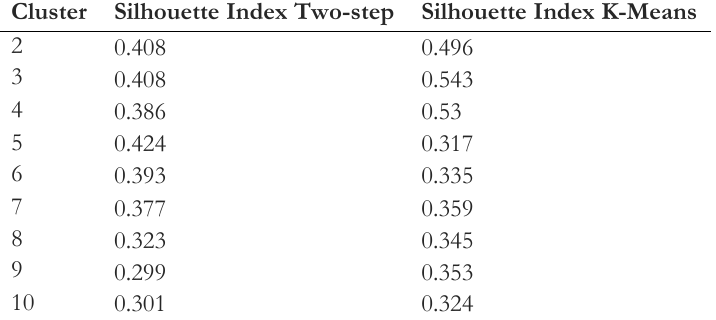
Table 9. Silhouette index amount for K-Means and two-step algorithm for the third